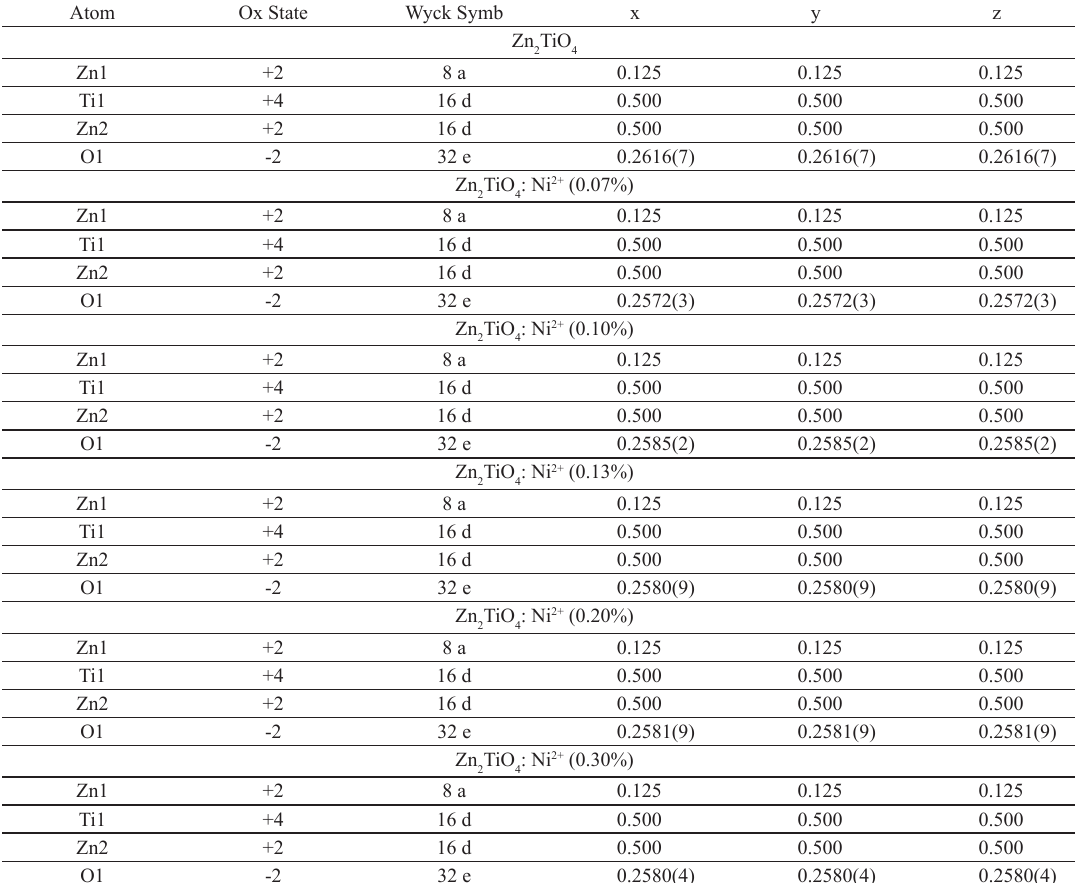
Table 2. Atomic positions obtained from Rietveld refinements.